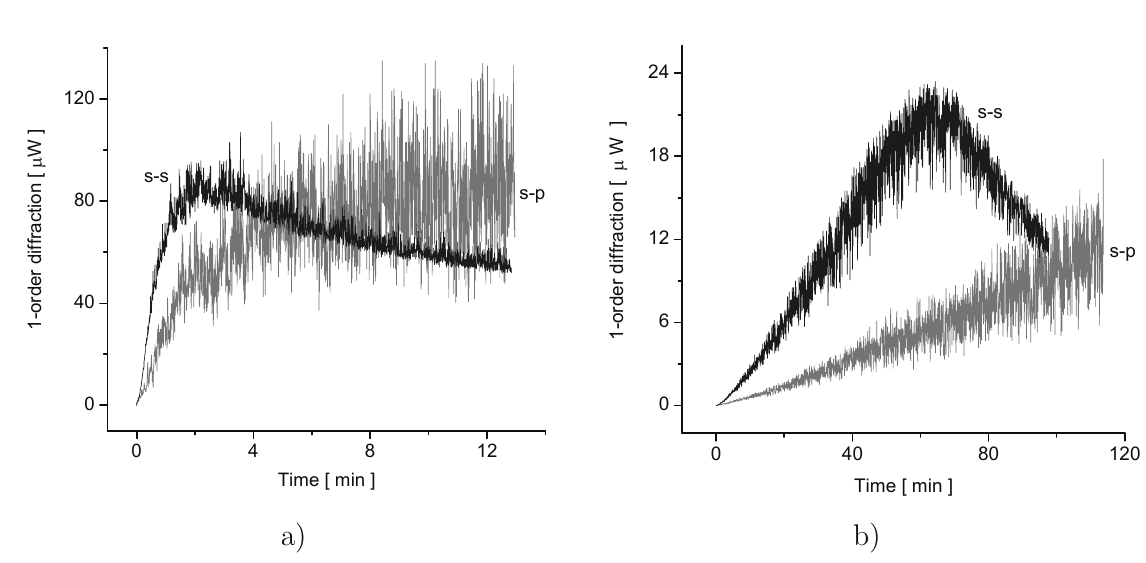
Fig. 7 Examples of a typical kinetics of grating build-up process during recording in poly(ester-imide) (1b) (a) and poly(amido-imide) (3c) (b). reorientation [24], and limited local mobility of azobenzene groups (determined by their size), the rigidity of the linkage between the chromophore group and the backbone, or the mobility of polymer chains at ambient